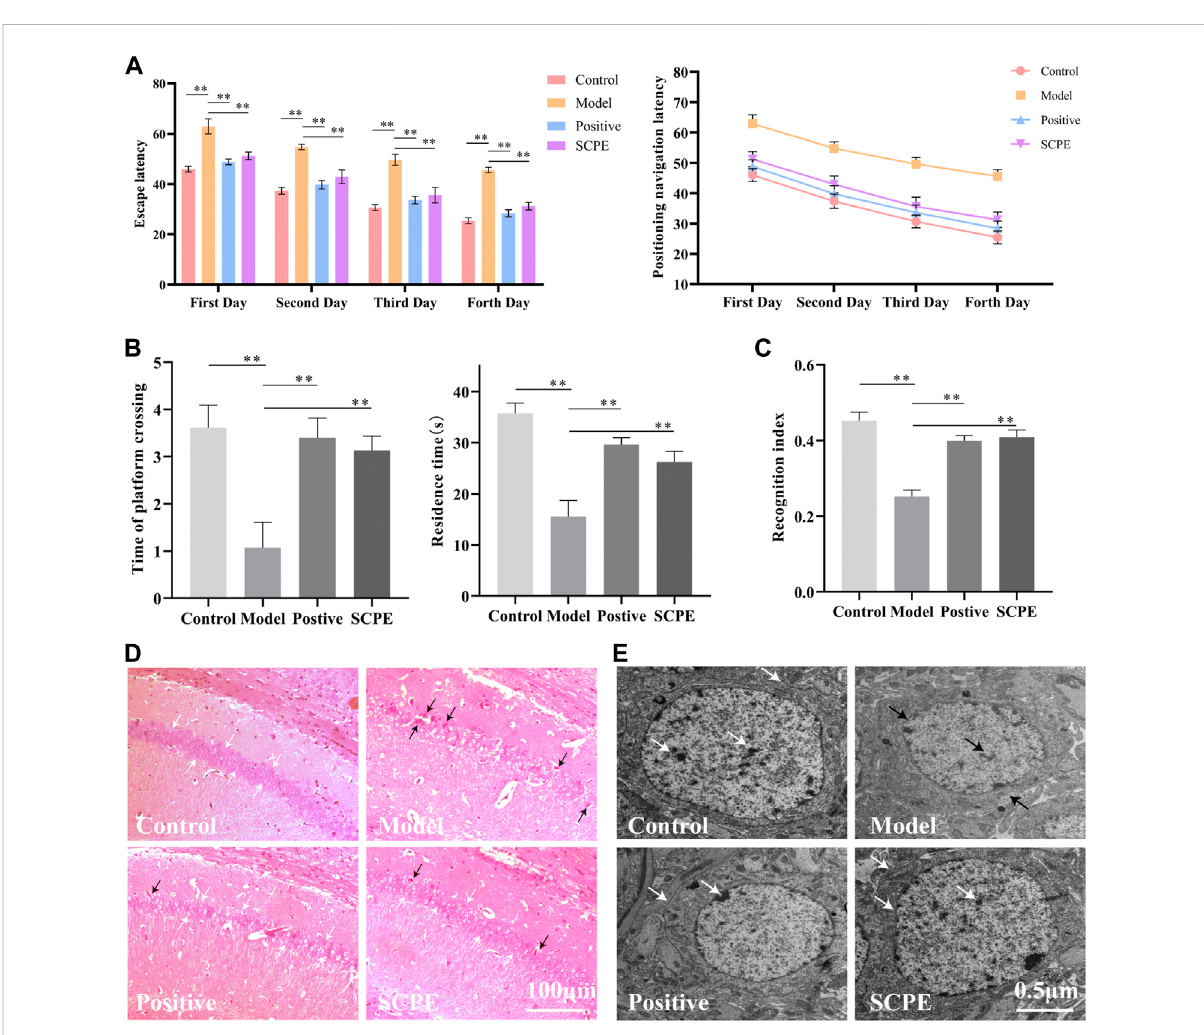
FIGURE 2 Analysis of SCPE on learning and memory ability and histomorphology of model mice. (A) Positioning navigation latency. (B) Time of platform crossing and residence time. (C) Recognition index. (D) H and E staining × 200. (E) Transmission electron microscope × 22000. Data in (A – C) presented as the mean ± SD of fi fteen independent experiments. Data in (D – E) presented as the mean ± SD of three independent experiments.* p < 0.05, ** p < 0.01 compared with indicated groups. HE, hematoxylin and eosin.